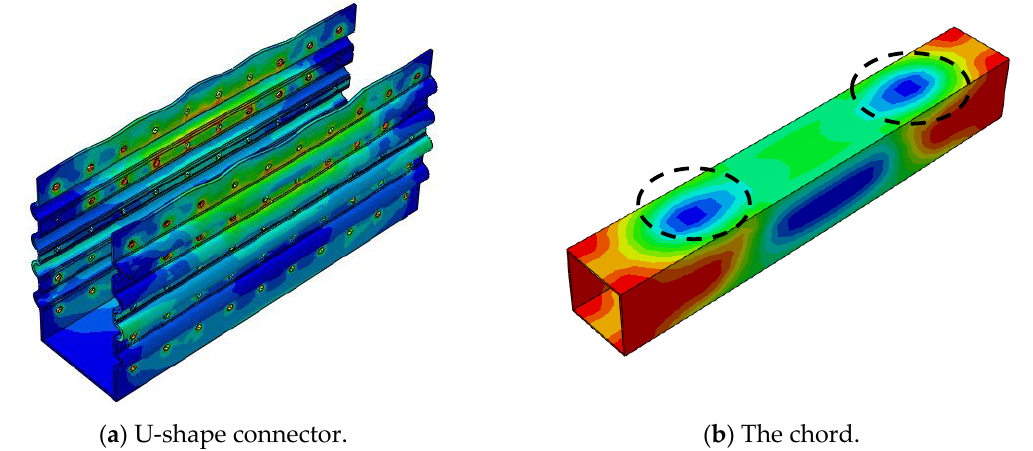
Figure 24. Deformation of the U-shape connector and displacement contour of the chord of FE model UTW-1.